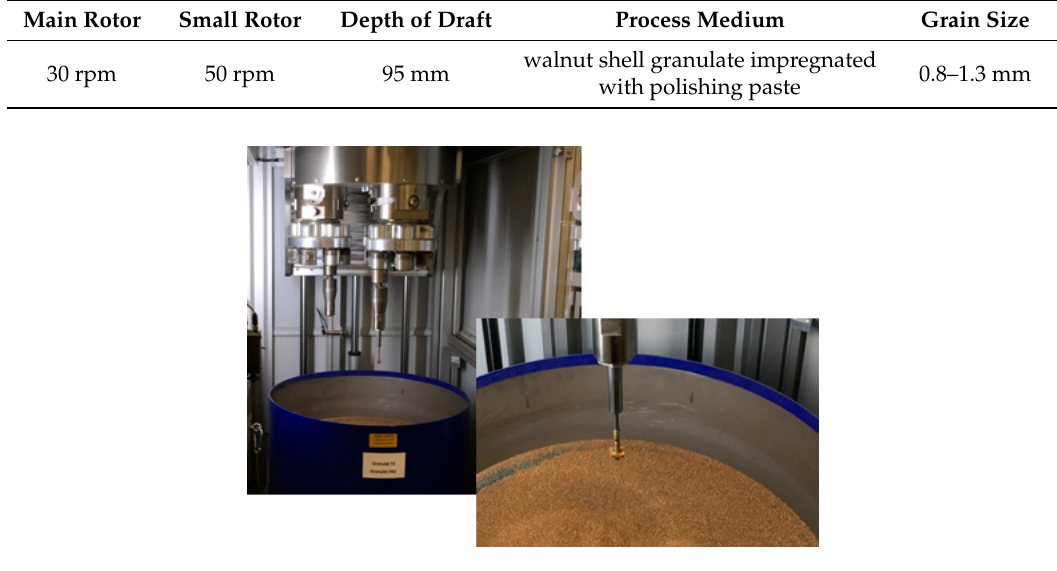
Figure 2. Drag finishing.